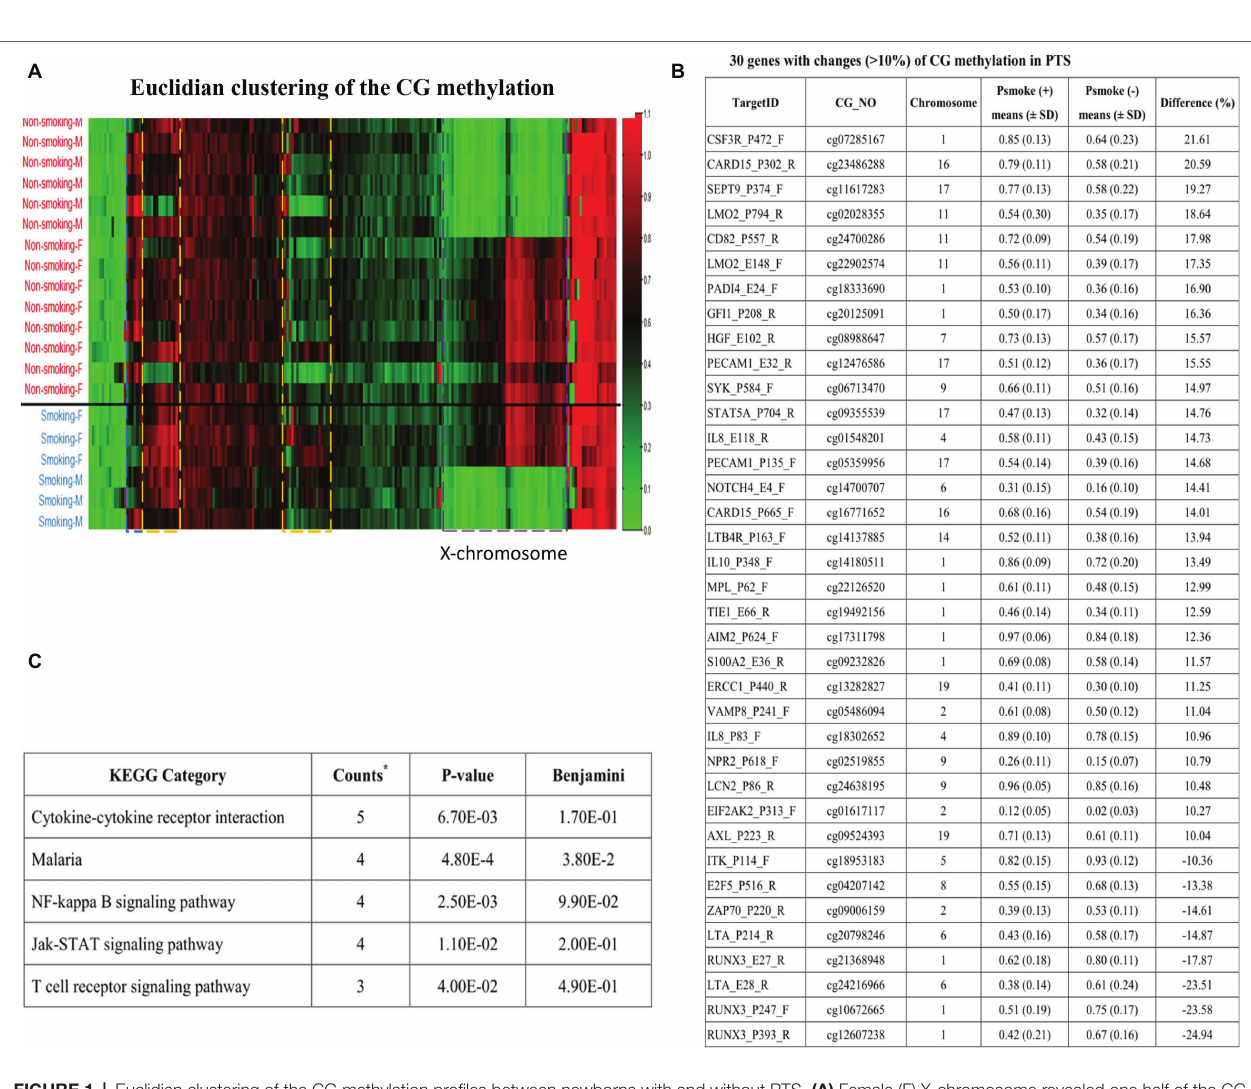
FIGURE 1 | Euclidian clustering of the CG methylation profiles between newborns with and without PTS. (A) Female (F) X-chromosome revealed one half of the CG sites were methylated (red color) but not male (M) ones (green), and there are other gene clusters associated with prenatal exposure of PTS (data deposited to the GEO Repository at accession number GSE129751); (B) Thirty-seven CG sites in 30 genes had 10% higher or lower CG methylated contents, in which 29 CG sites were higher and 8 CG sites were lower CG methylation; (C) The KEGG pathway analysis found five pathways including cytokine-cytokine receptor interaction, malaria defense, NF-kappa B signaling, Jak-STAT signaling, and T cell receptor signaling pathways were significantly involved in CG methylation changes associated with prenatal exposure of PTS. The five genes in cytokine-cytokine receptor interaction are IL8, MPL, CSF3R, IL10, and LTA; the four genes in Malaria defense are IL8, HGF, IL10, and PECAM1; the four genes in NF-kappa B signaling pathway are IL8, LTA, SYK, and ZAP70; the four genes in Jak-STAT signaling pathway are MPL, CSF3R, IL10 and STAT5A; and the three genes in T cell receptor signaling pathway are ITK, IL10, and